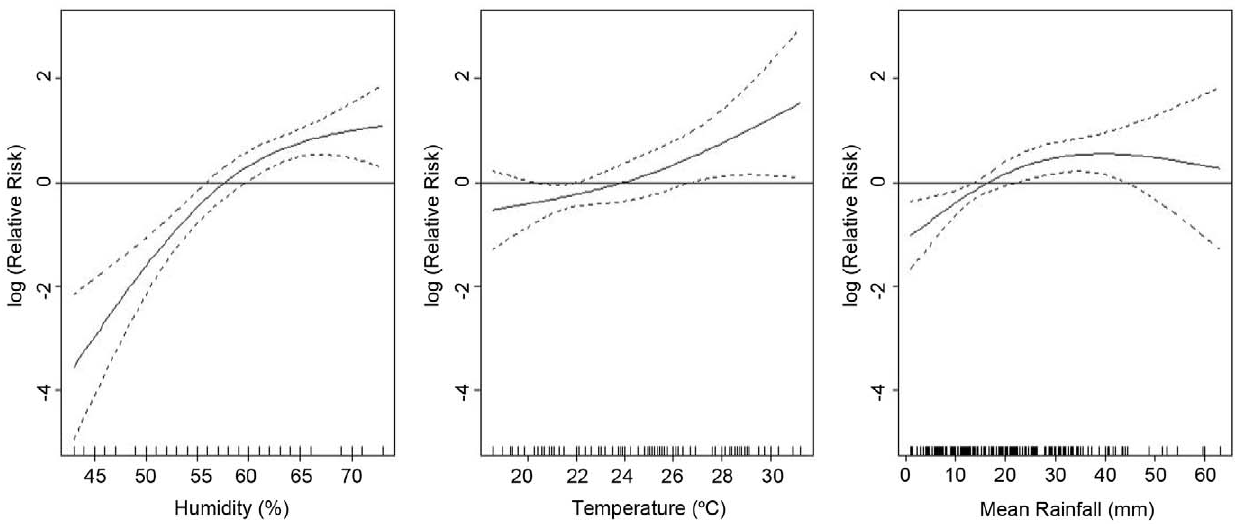
Figure 5. Adjusted relationship between ZCL incidence and humidity, temperature and rainfall. There were no turning points in the relation between temperature/humidity and ZCL incidence. Therefore, we assume these relationships as linear. For rainfall lagged by 12 to 14 months, a turning point equal to 37.34 exists. The range, from each plot, that the climate variables have a positive effect on ZCL incidence is over the zero axis.